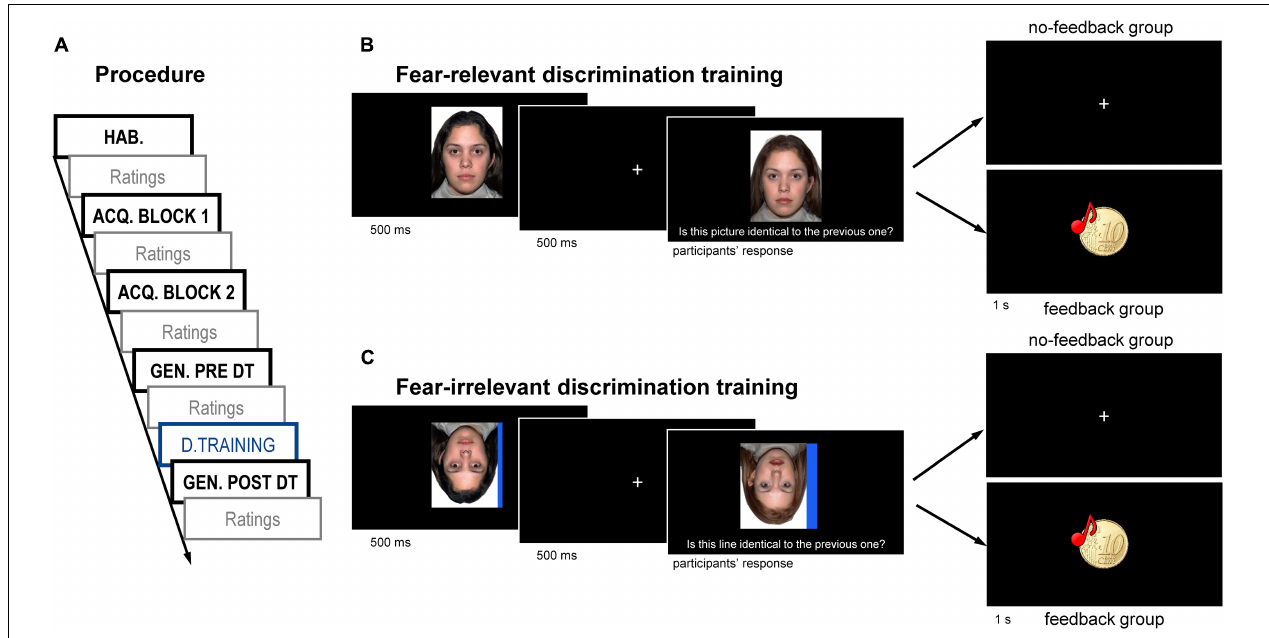
FIGURE 1 | Overview of the experimental procedure (A) as well as of the fear-relevant discrimination (B) and fear-irrelevant discrimination (C) trainings, both with and without feedback. The discrimination training was surrounded by two generalization blocks, pre- and post-discrimination training, and the participants were divided into four groups: two groups underwent a fear-relevant discrimination training, and the other two groups underwent a fear-irrelevant discrimination training. Firstly, the participants saw a stimulus (CS+ for the fear-relevant training, a line for the fear-irrelevant training) for 500 ms, which was always the same. After 500 ms of inter-stimulus interval, a second stimulus was presented until the participants indicated whether the second stimulus was identical with the first stimulus or not. The second stimulus was for the fear-relevant discrimination training, the CS+, the CS–, or any of the generalization stimuli, and for the fear-irrelevant discrimination training a line with the same or a different width. Half of the participants received reinforcing feedback for correct answers (feedback groups; feedback for correct answers was a compound stimulus of a 10-Euro-cent picture and a cash register sound lasting 1 s and no feedback for incorrect answers), while the other half never received feedback (no-feedback groups). The face pictures presented here have been obtained from the NimStim Face Stimulus Set by Tottenham et al. (2009), some of which were further processed by morphing. They are examples and differ from the pictures